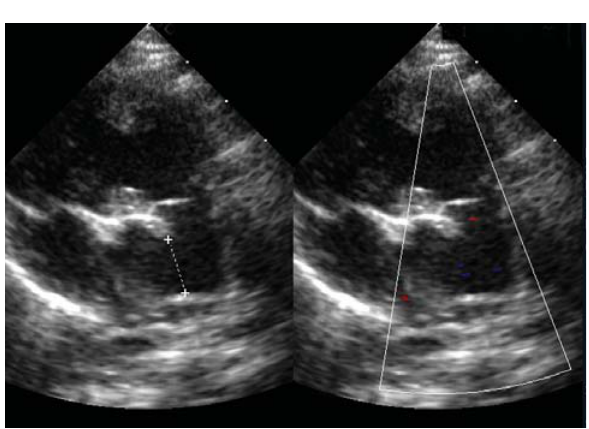
Fig. 1 – Ecocardiograma bidimensional paraesternal eixo curto, demonstrando a comunicação entre o tronco pulmonar (antes da bifurcação dos ramos pulmonares) e a aorta